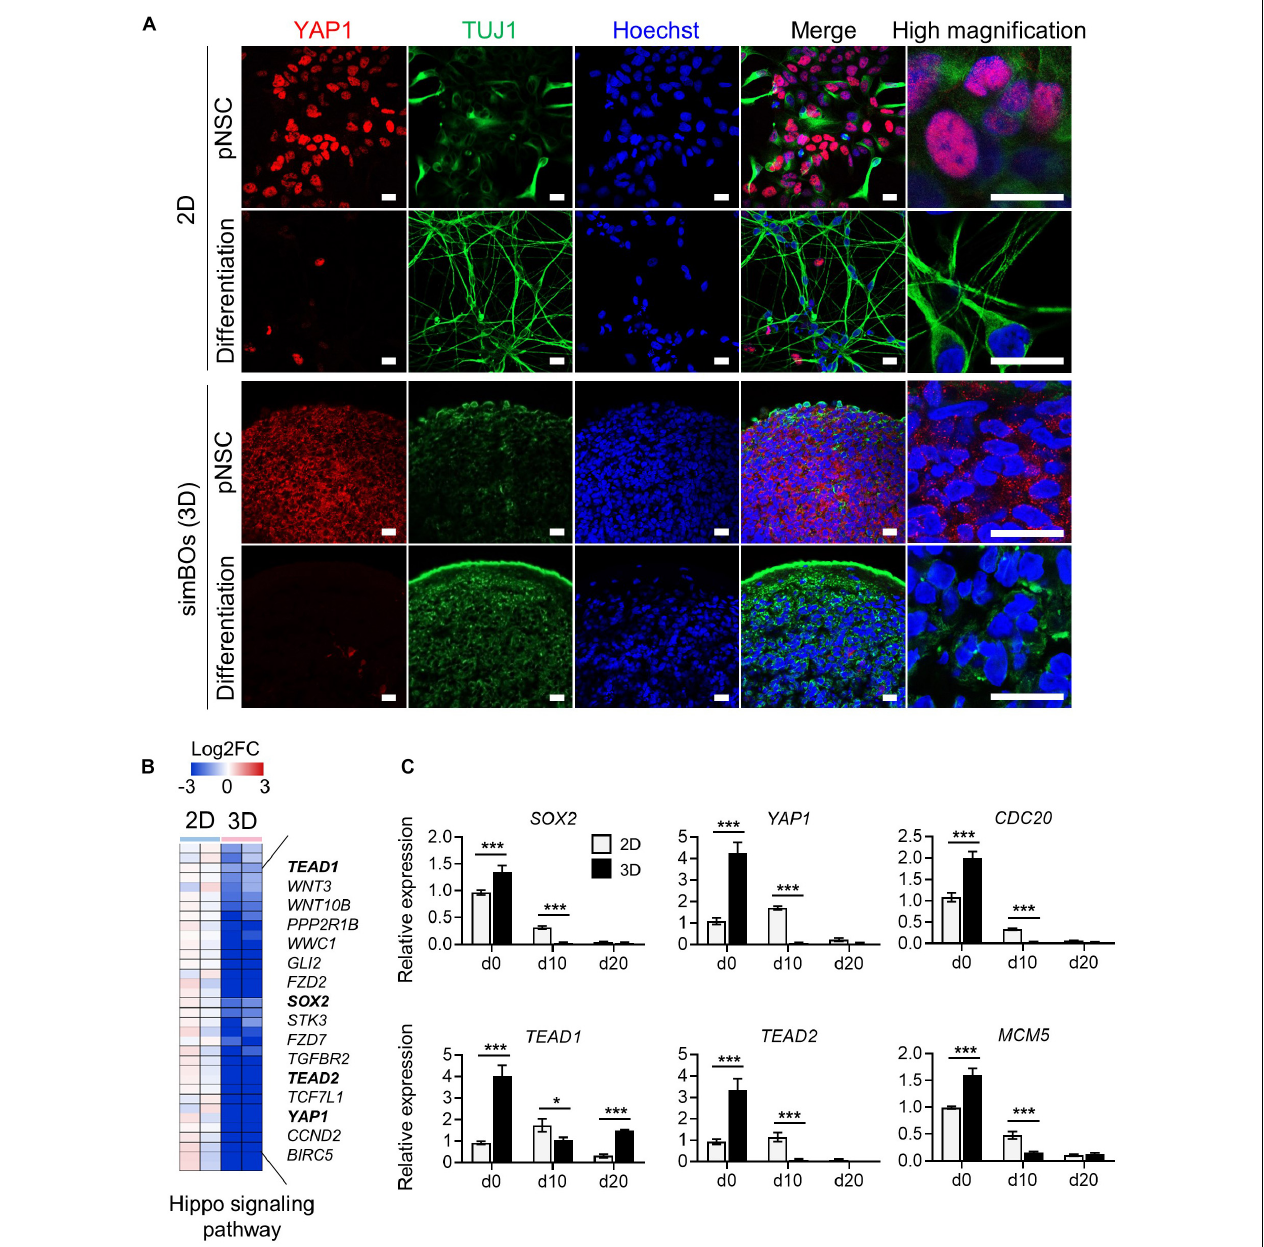
FIGURE 5 | Subcellular localization and transcription regulation of YAP1. (A) Subcellular localization of YAP1 and TUJ1. Scale bars represent 20 µ m. (B) Heat map for the Hippo signaling pathway genes differentially expressed during 2D and 3D differentiation. Representative gene names were presented in right panel and color scale was presented upper panel. (C) Quantitative reverse transcription polymerase chain reaction (qRT-PCR) analysis for YAP1 and direct targets of YAP1 ( SOX2 , TEAD1 , TEAD2 , CDC20 , and MCM5 ) in simplified brain organoids (simBOs; 3D) and 2D differentiation samples. Expression value was normalized to those of